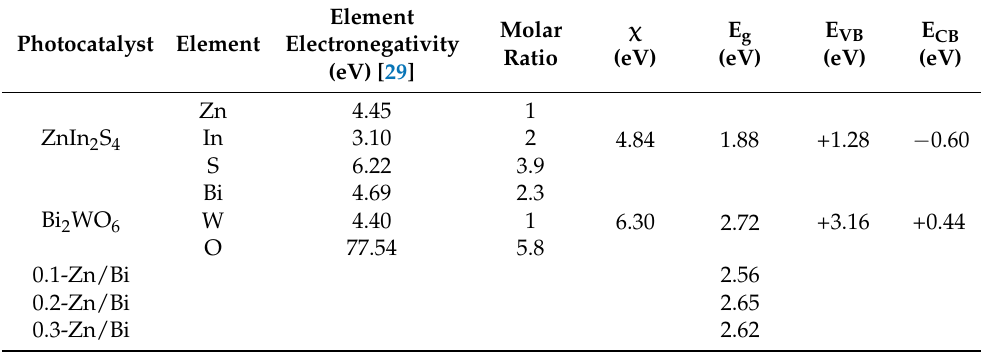
Table 2. The calculated results of band gap energy and band gap potential of as-prepared photocatalyst.